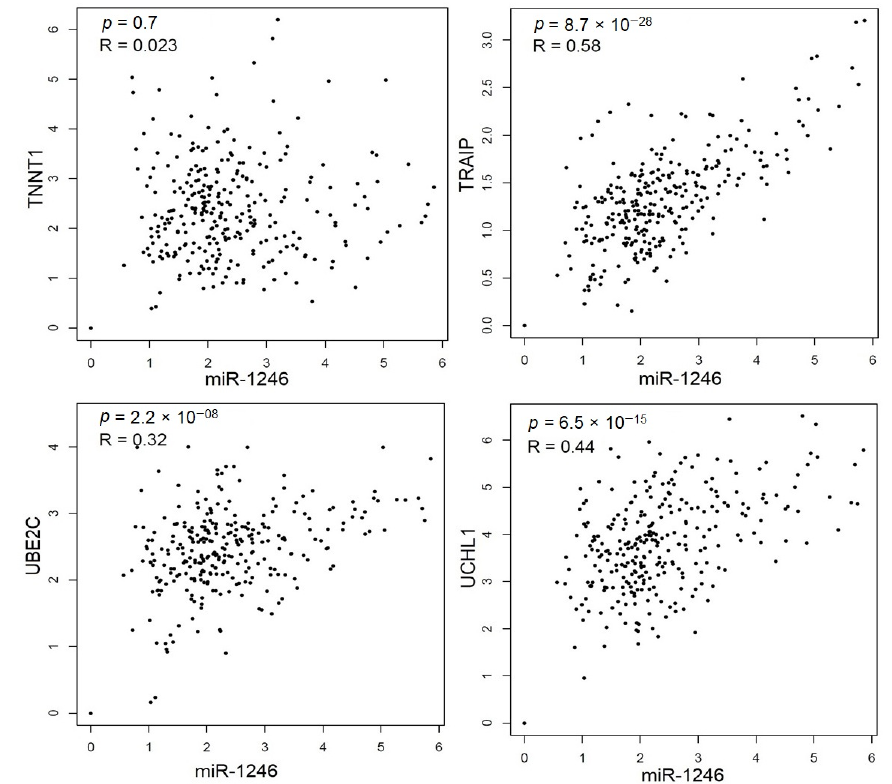
Figure 7. Correlation analysis between miR-1246 and 4 PTGs: UBE2C ( r = 0.32, p = 2.2 × 10 − 08 ), TNNT1 ( r = 0.023, p = 0.07), TRAIP ( r = 0.58, p = 8.7 × 10 − 28 ), and UCHL1 ( r = 0.44, p = 6.5 × 10 − 15 ).